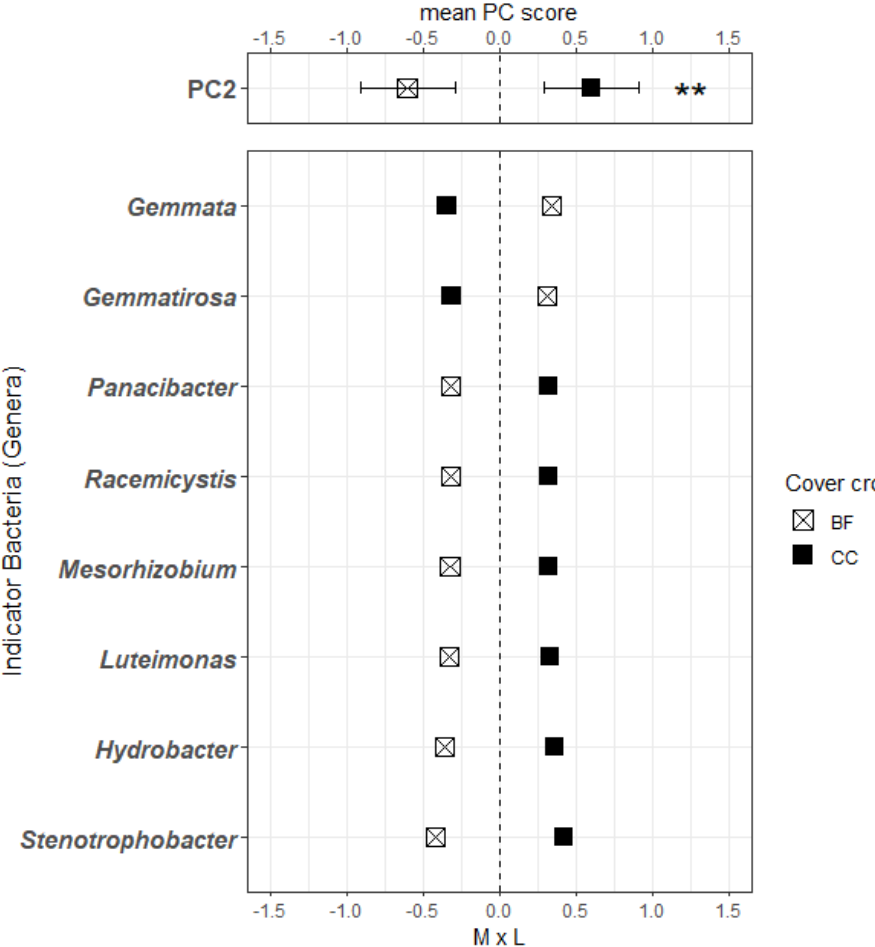
Figure 2. The top panel shows the estimated mean principal component (PC) scores of the bacterial PC2 for each level of cover cropping treatment with their standard errors as whiskers. The asterisks indicate the probability value of the treatment effect from analysis of variance (**: p < 0.05). The bottom panel shows the contribution of each bacterial indicator to PC2 multiplied by the mean PC scores of each level of cover cropping treatment (M × L). The treatment levels are bare fallow (BF; crossed box) and cover crop mixture (CC; filled box).